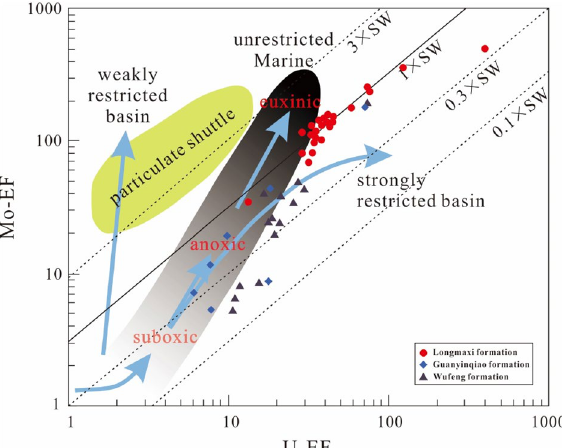
Figure 13. Plot of Mo EF vs. U EF from the studied samples normalized using shale data 56 . The solid line shows the Mo–U molar ratio equal to the seawater value (1 × SW). Dashed lines indicate Mo–U molar ratios equal to fractions of seawater values 110,114 (3 × SW, 0.3 ×